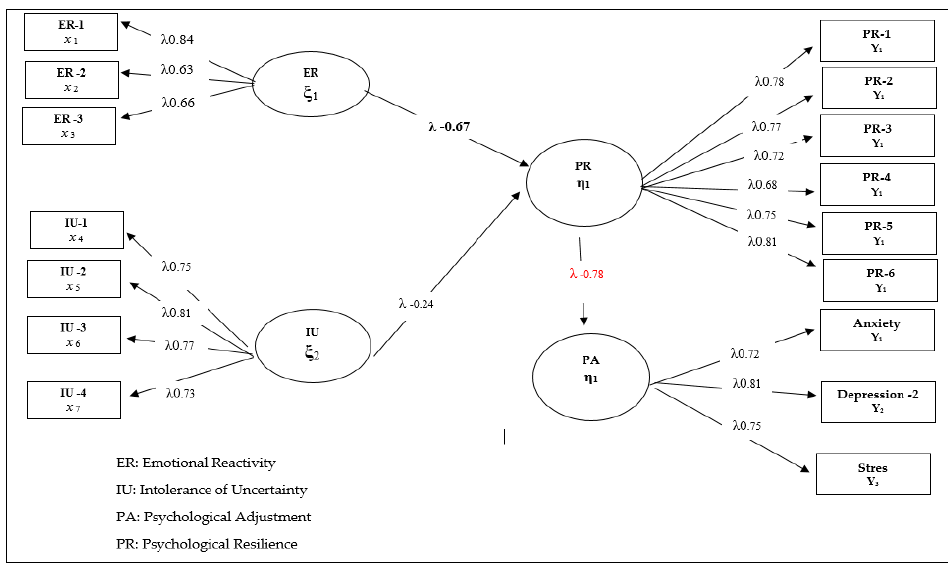
Figure 3. Standardized SEM results for Model 3. (Figure S3).